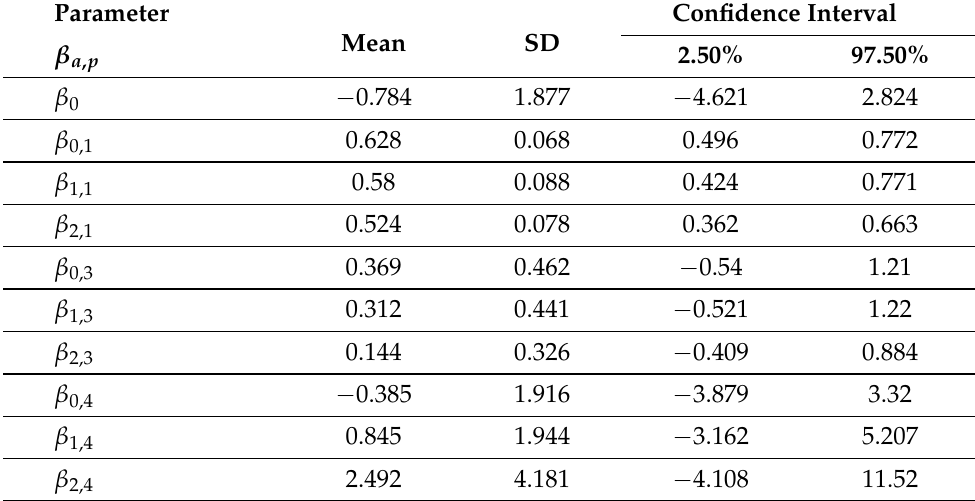
Table 5. Main parameter values of BHBB.